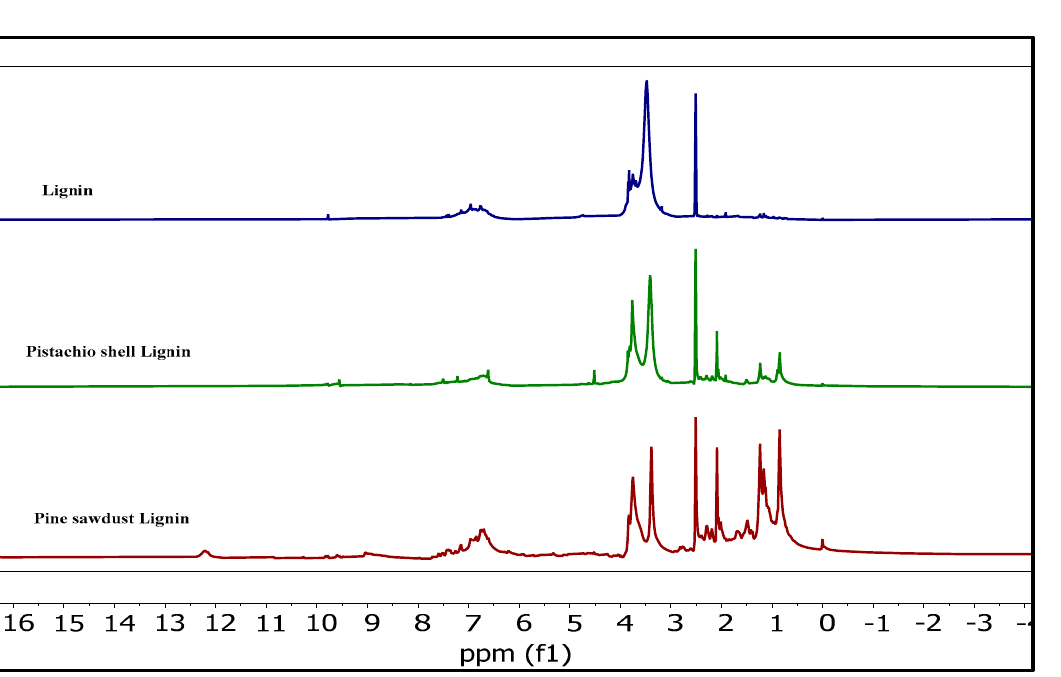
Table 2. 1 H NMR chemical shifts and functional groups of extracted lignin from pine sawdust and pistachio shells.